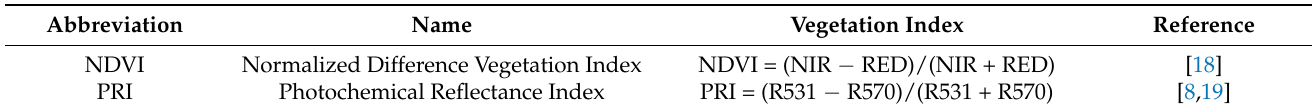
Table 1. List of reflectance indices used in this research project to assess plant water and nitrogen stress and correlate the results with vegetation